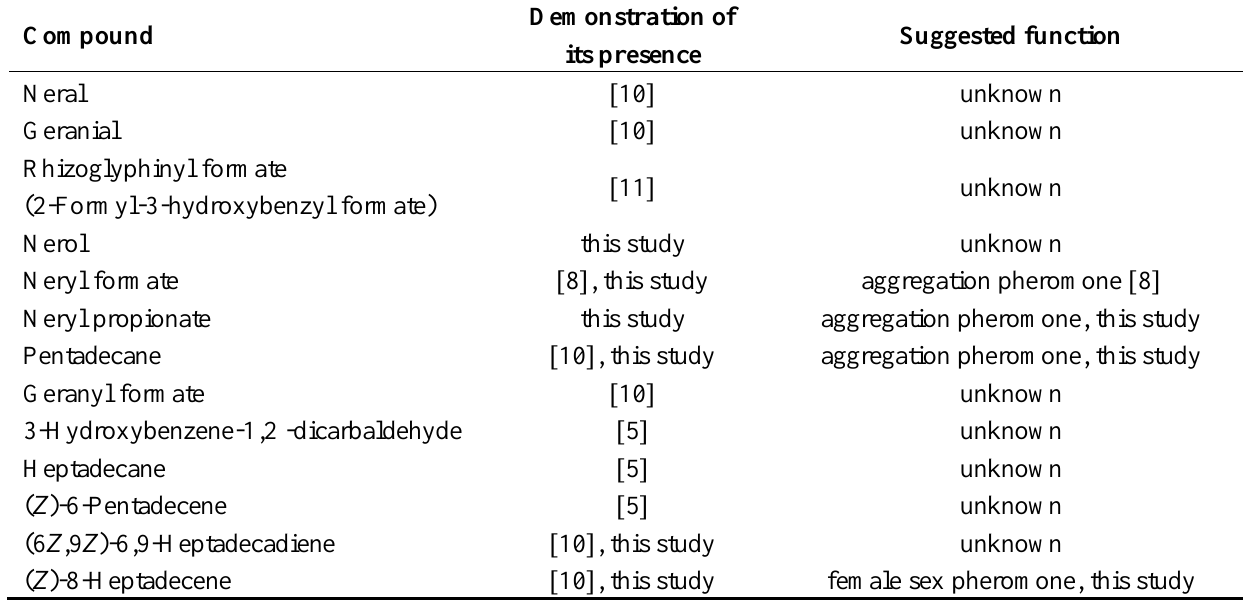
Table 1. Chemical compounds released by the house dust mite D. pteronyssinus and their proposed pheromonal function as reported in the literature and discussed in the present